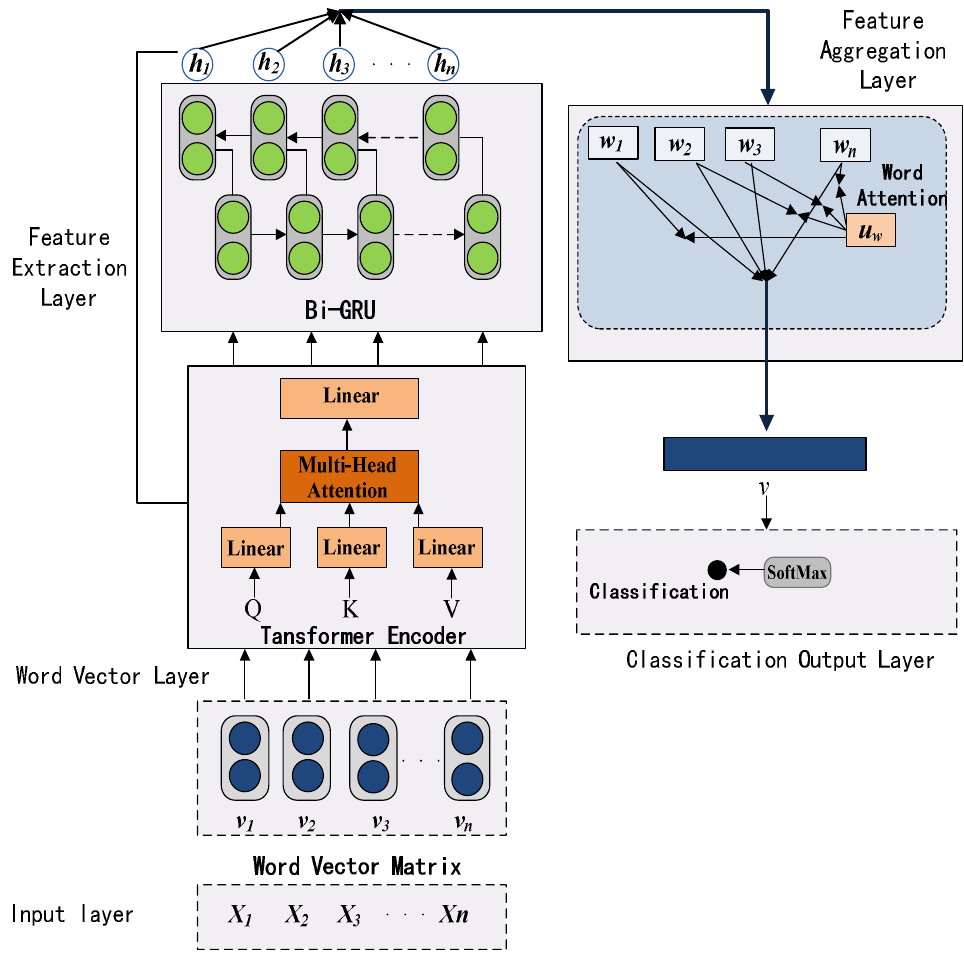
Figure 2. The structure of the TBGA model.